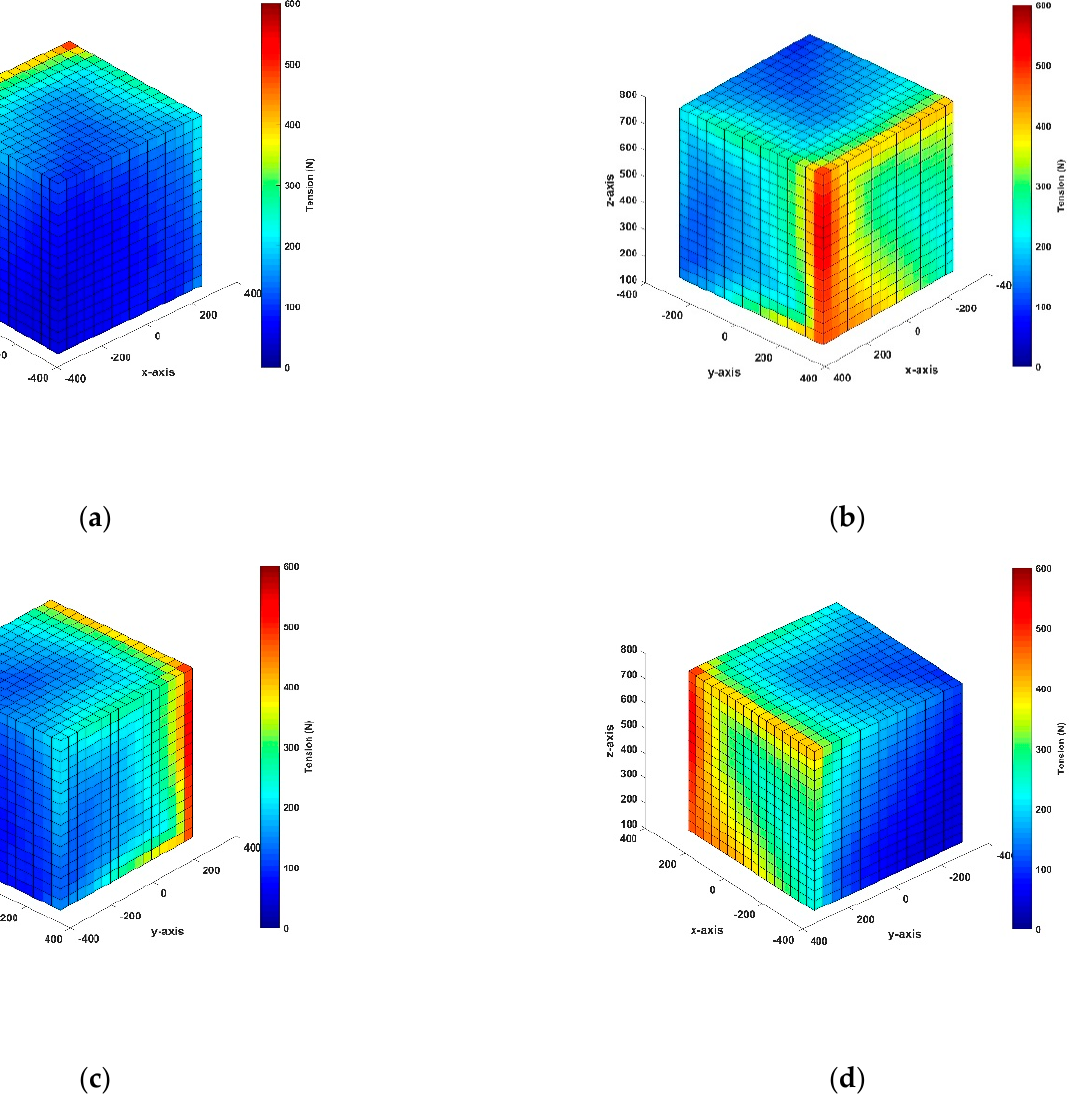
Figure 7. Overall workspace simulation at the acceleration of 10 m/s 2 : ( a ) front plane of the X –axis; ( b ) back plane of the X –axis; ( c ) front plane of the Y –axis; ( d ) back plane of the Y